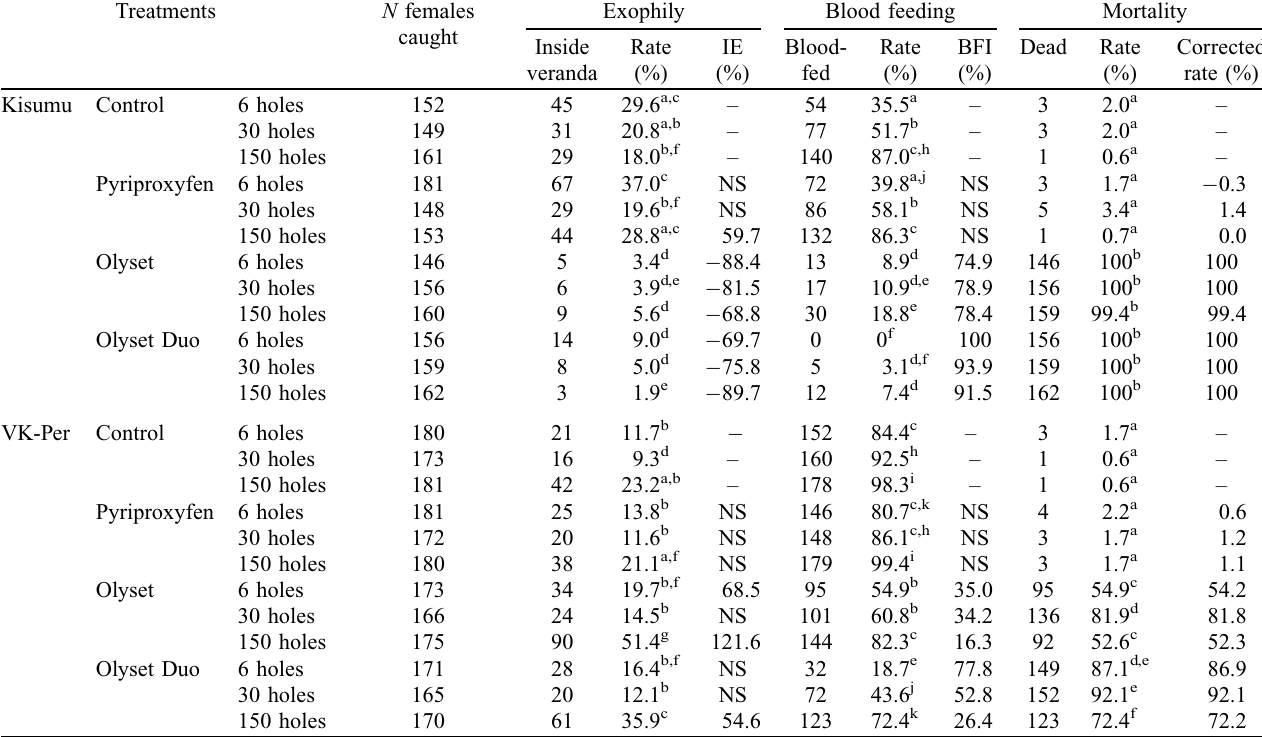
Table 1. Summary results of the release-recapture of An. gambiae s.s. (Kisumu and VK-Per strains) relative to the treatments and holing